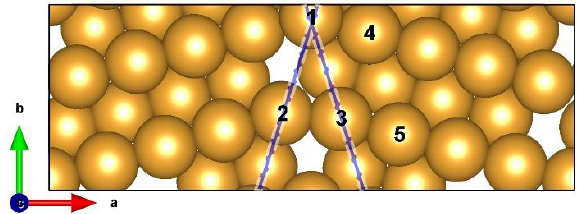
Figure 1. Top view of the Σ6{2–21} HAGB model on Au(110) surface with three atomic layers in an orthogonal supercell (25.29 × 8.94 × 17.80 Å 3 ). The GB area is highlighted by blue lines. The selected Au around GB is labeled as s1–s5.